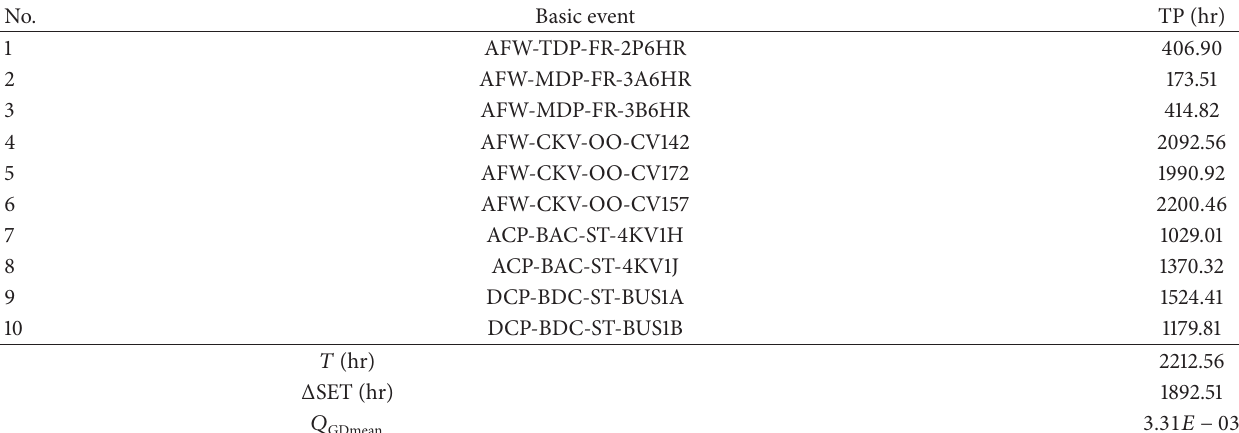
Table 8: Obtained optimal test placement times for case scenario 2 with consideration of the Δ